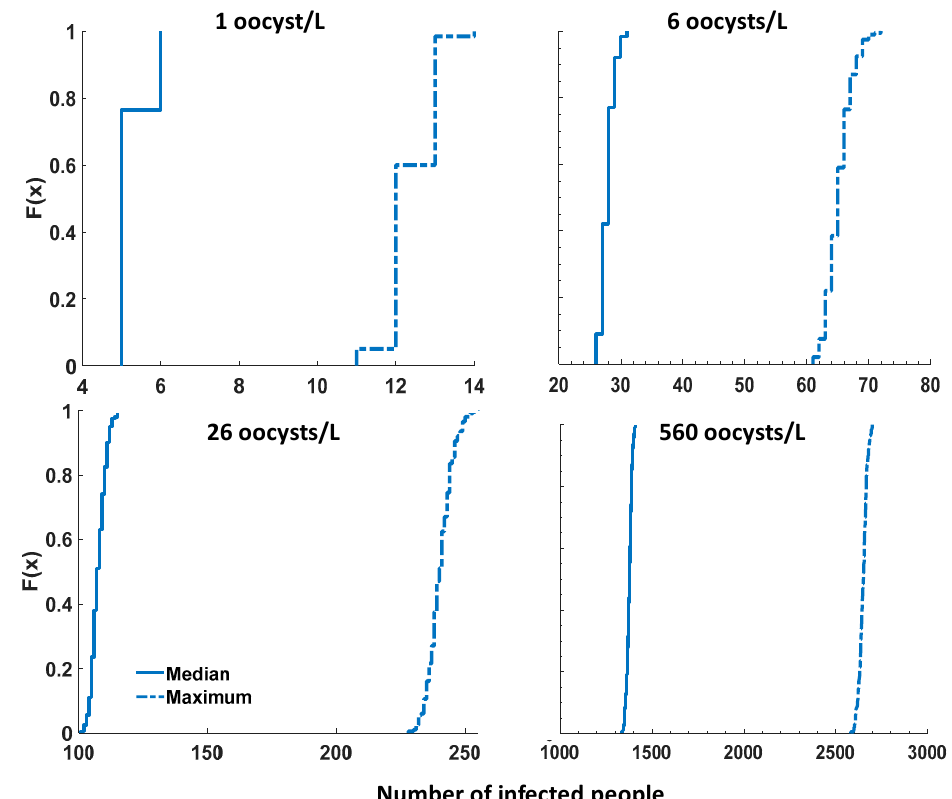
Figure 4. Number of infected people corresponding to median and maximum infection risks resulting from a 24-h depressurization; 200 Monte Carlo simulations (consumption events) for each Cryptosporidium concentration: 1, 6, 26, and 560 oocysts / L; number of infected people corresponds to the cumulative dose over four days of observation; F(x): probability that the median / maximum number of infected people will be less than or equal to x.